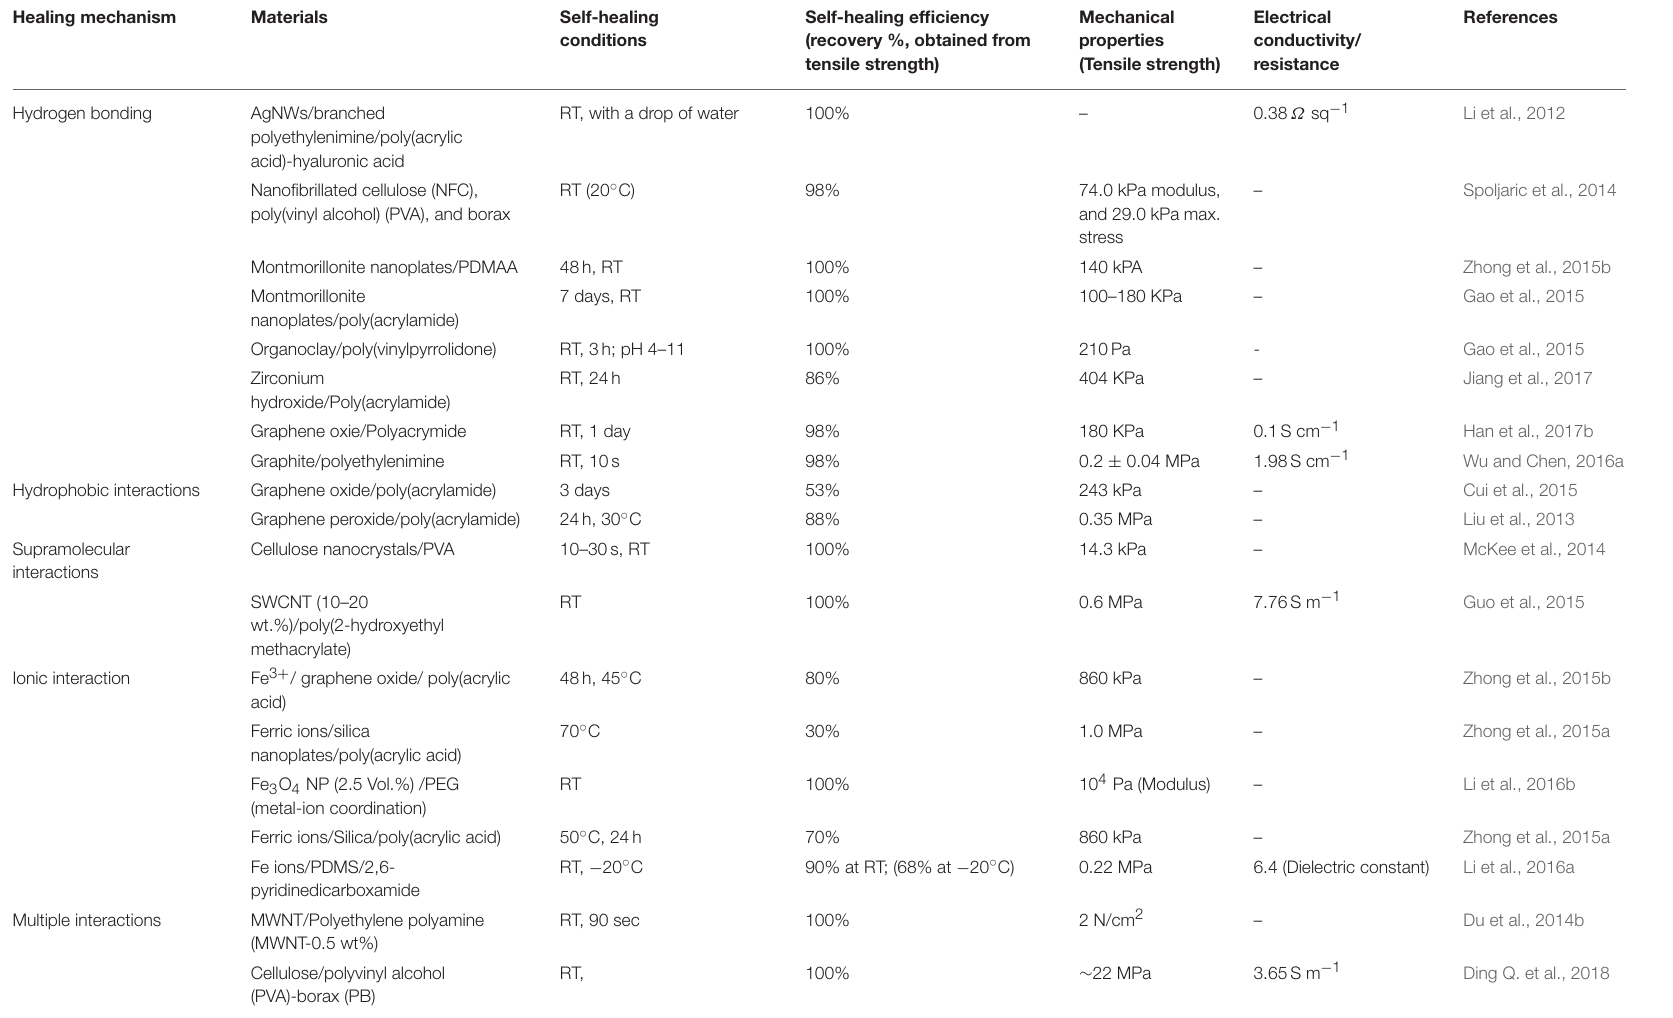
TABLE 2 | Physical interaction based self-healing mechanism, healing efficiency, recovery, mechanical/electrical properties of soft nanocomposites. Healing